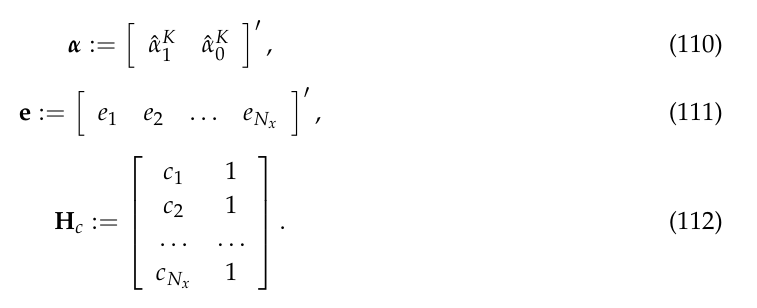
( h ( x )) versus x 10